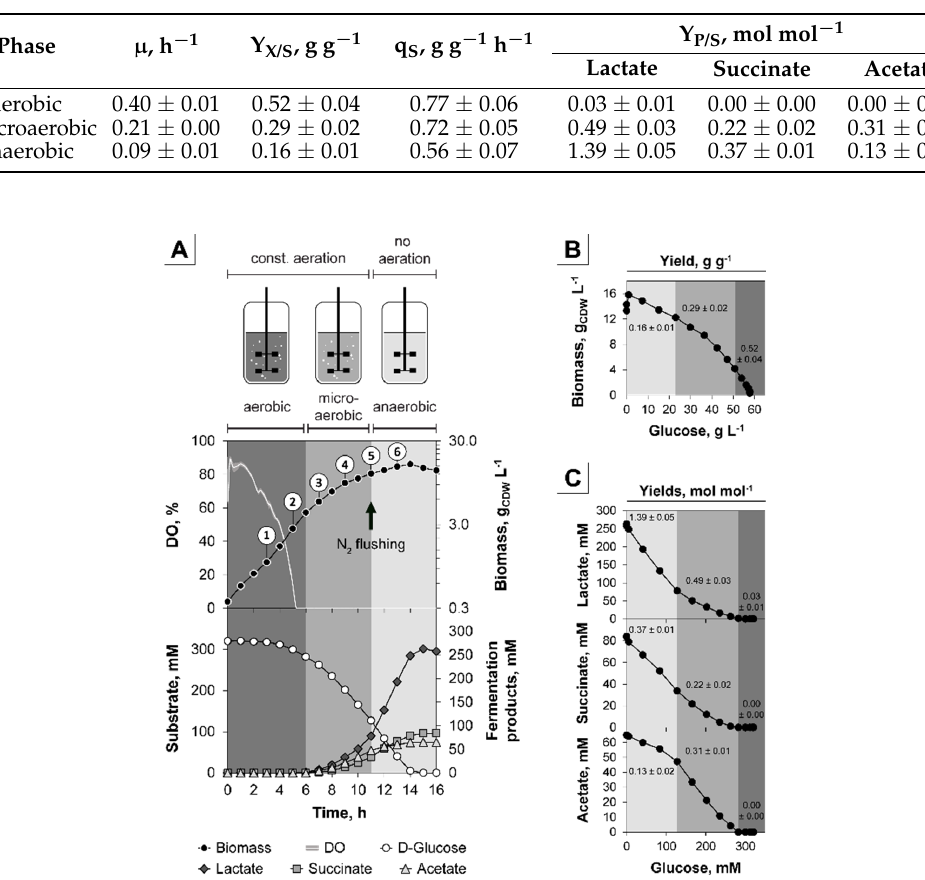
Figure 1. The triple-phase process with Corynebacterium glutamicum cultivated in CGXII + 60 g glucose L − 1 . ( A ) The 30 L bioreactor cultivation in 10 L minimal medium was realized with constant agitation (445 rpm) throughout the entire process and a gassing of 0.1 vvm within the aerobic (dark grey) and microaerobic (grey) phase. The anaerobic (light grey) phase was initiated by a stop of aeration and temporary flushing of the headspace with N 2 . Sampling for e.g., RNA-sequencing analysis is indicated with circled numbers ( ① , ② , ③ , ④ , ⑤ , ⑥ ); ( B ) Biomass/substrate yield (Y X/S ); ( C ) Product/substrate yields (Y P/S ). Error bars and shaded area of the dissolved oxygen (DO) represent the standard deviation (SD) of four independent experiments.